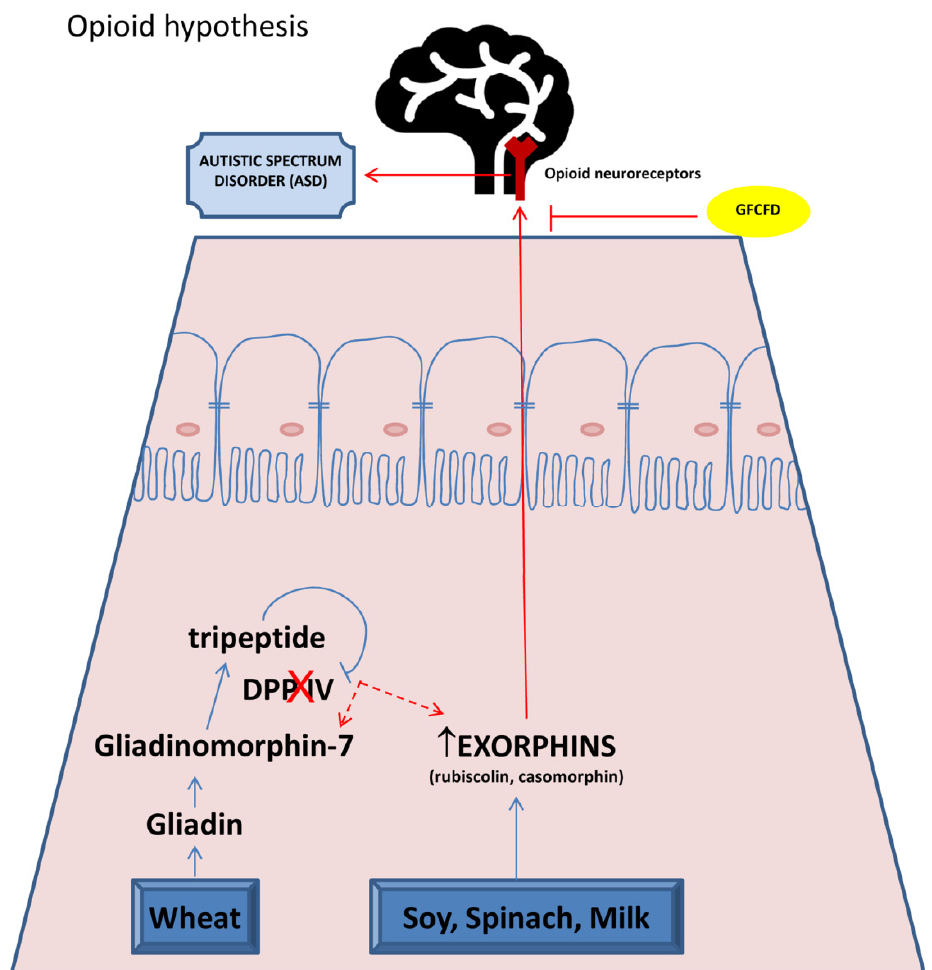
Figure 1. “Opioid hypothesis”. In celiac patients, the incomplete digestion of proteins derived by wheat and milk produces peptides called gliadinomorphin-7 and exorphins (gliadorphin, rubiscolin, casomorphin). The lack of protease DPP-IV favors the conversion of gliadinomorphin-7 in exorphins. Exorphins cross gut barrier and blood–brain barrier and are able to bind and stimulate opioid